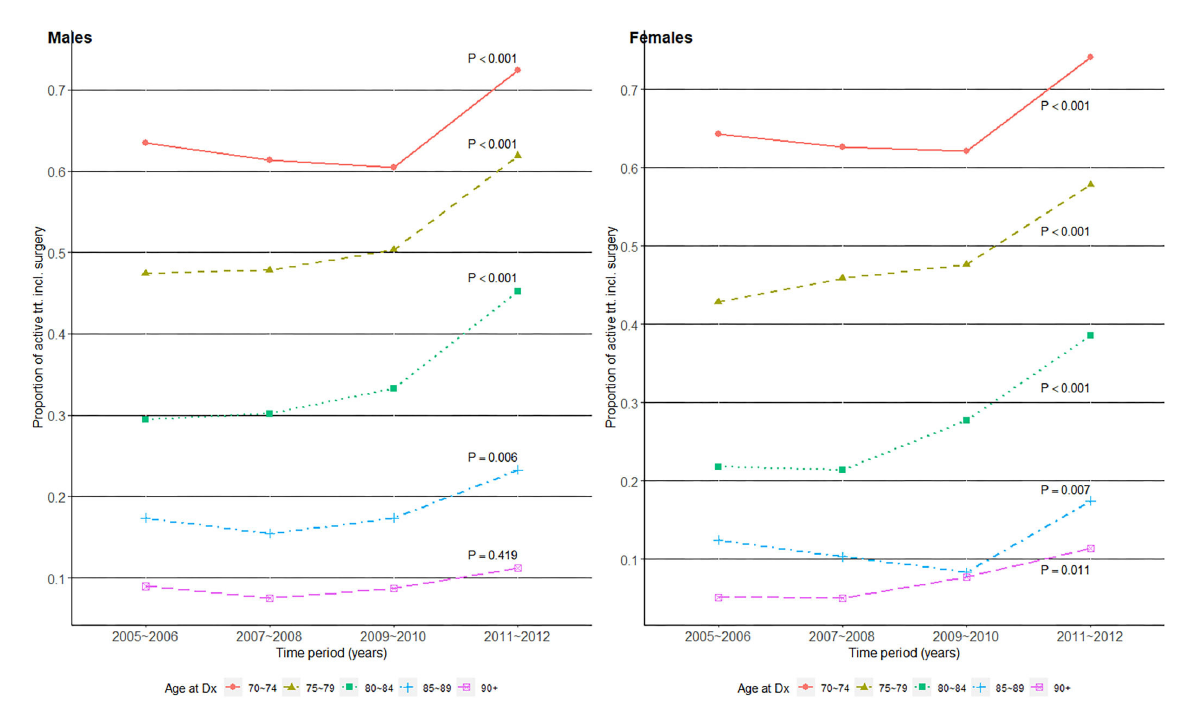
FIGURE2 Surgery-including active treatment proportions over the four time periods of gastric cancer diagnosis in 2005–2012, among older (age at Dx 70 ) patients with gastric cancer in +